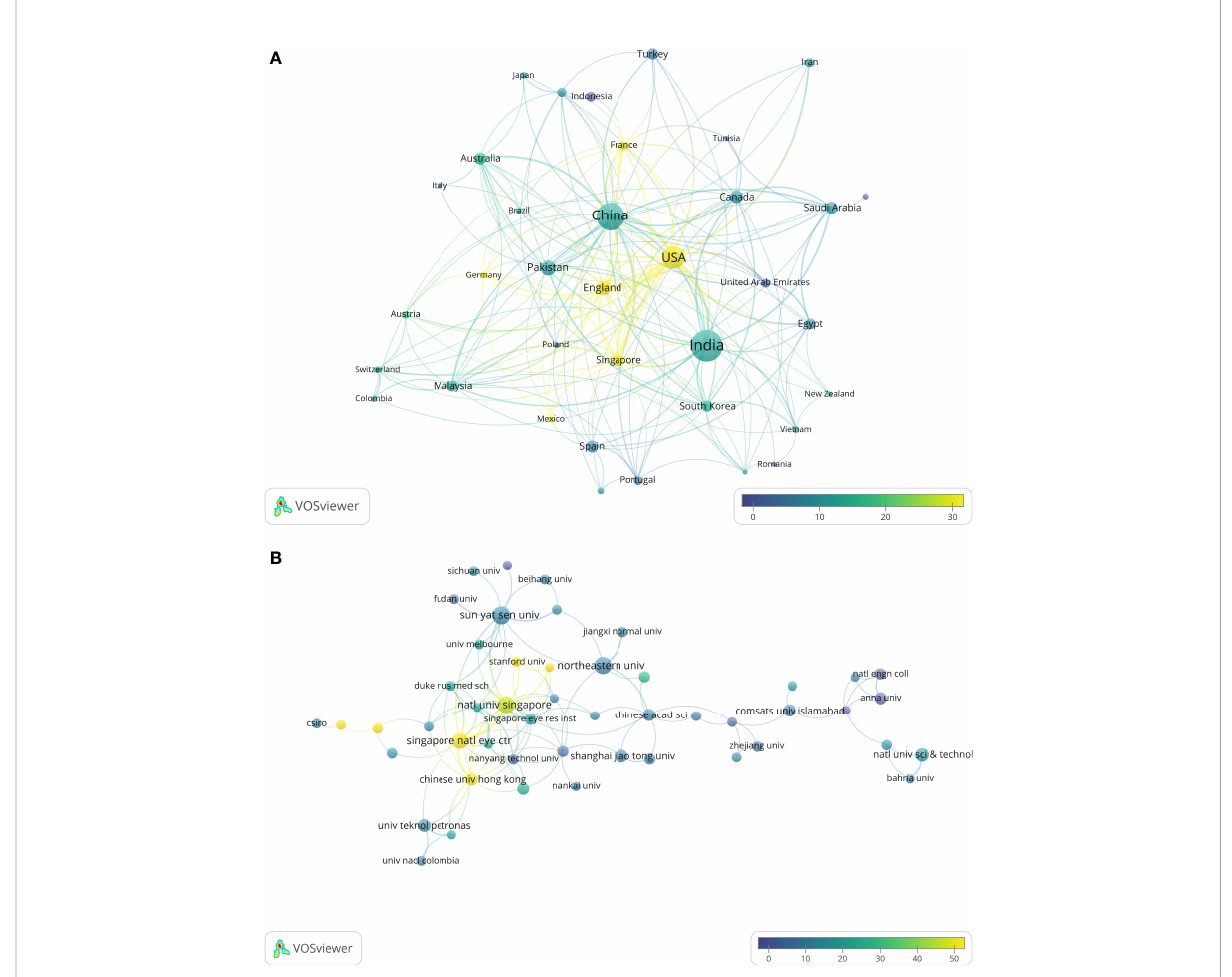
FIGURE 3 Collaboration maps between countries and institutions. (A) Highly contributed countries. (B) Highly contributed institutions. Circle size represents the publication count; circle color represents average citations; links represent the